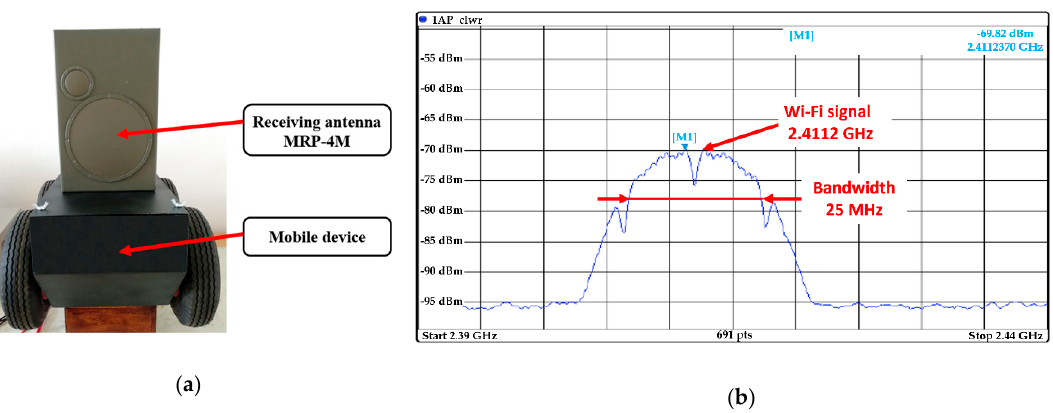
Figure 19. Remote-controlled mobile interference device in receiving mode ( a ) with receiving antenna; ( b ) detected Wi-Fi signal transmitted by a commercial router.